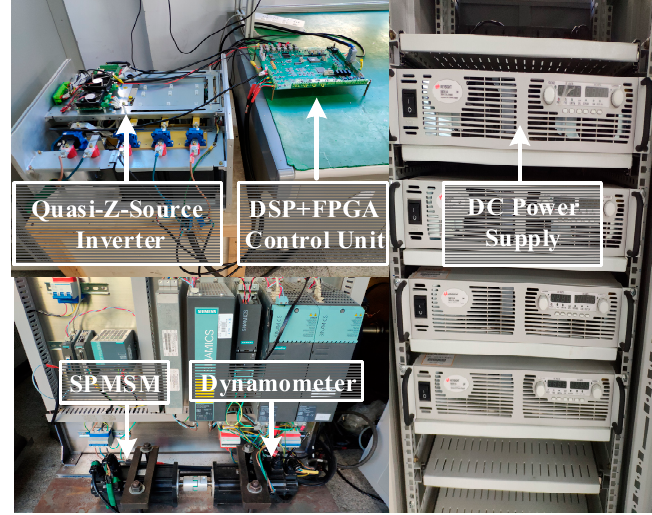
Figure 9. Diagram of experiment prototype.